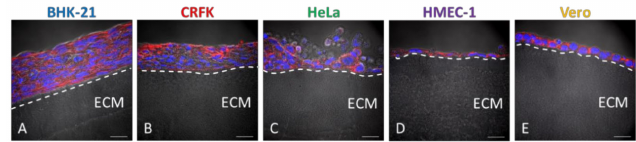
Figure 3. Morphological characterisation of di ff erent cell lines grown on Wellbricks. BHK-21 ( A ), CRFK ( B ), HeLa ( C ), HMEC-1 ( D ), and Vero ( E ) cells were cultivated on Wellbricks with the defined optimal matrix composition (10 wt% gelatine, w / o Collagen A) for 7 days. The 8 µ m cryosections of the specimens were analysed by microscopy. Sections were treated with CF594 (red)-coupled wheat germ agglutinin (WGA) for staining of sialic acids and N-acetylglucosamin on cell membranes. Cellular nuclei were counterstained with DAPI (blue). Matrix structure (beneath the layer(s) of cells) was visualised in the brightfield channel. Scale bar = 20 µ m. ( A – E ) The border between matrix and cell layer has been visualised with a dashed line and extracellular matrix (ECM) has been marked for ease of orientation.